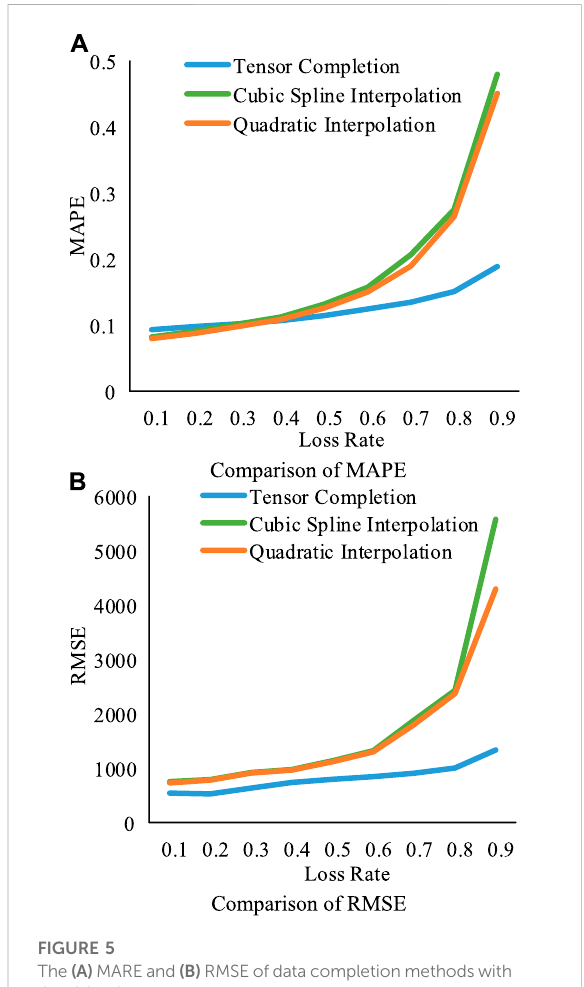
FIGURE 5 The (A) MARE and (B) RMSE ofdata completion methodswith the rising loss rate.